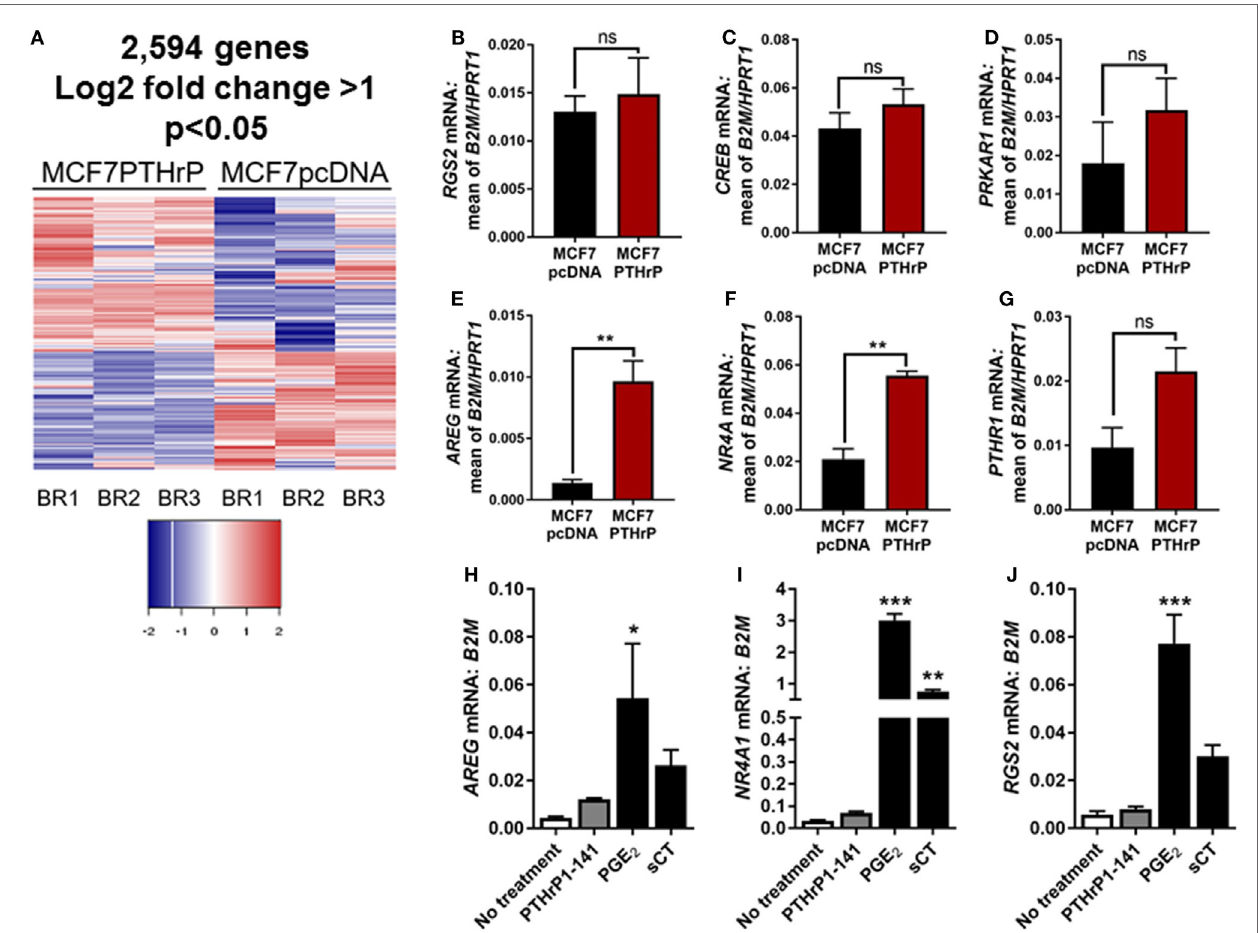
FigUre 3 | Parathyroid hormone-related protein (PTHrP) overexpression does not induce cyclic AMP (cAMP) target genes. (a) Heat map of gene expression with 95% confidence intervals in MCF7pcDNA (empty vector control) or MCF7 PTHrP-overexpressing cells. BR1 = biological replicate 1, BR2 = biological replicate 2, BR3 = biological replicate 3. (B–g) qPCR for cAMP target genes in MCF7pcDNA or MCF7 PTHrP-overexpressing cells. mRNA levels were normalized to the geometric mean of B2M and HPRT1 housekeeping genes. Graphs = mean + SE. ** p < 0.01 by unpaired Student’s T -test. (h–J) qPCR for cAMP target genes in MCF7 cells following stimulation with PTHrP(1–141) or positive controls prostaglandin E 2 (PGE 2 ) or salmon calcitonin (sCT). Graphs = mean + SE. n = 3 replicates from independent experiments. * p < 0.05, ** p < 0.01, *** p < 0.001 vs no treatment by one-way ANOVA with multiple